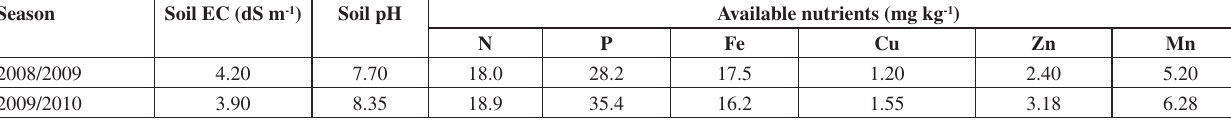
Table 2/B: Physical and chemical analysis of the experimental soil in 2008/2009 and 2009/2010 seasons